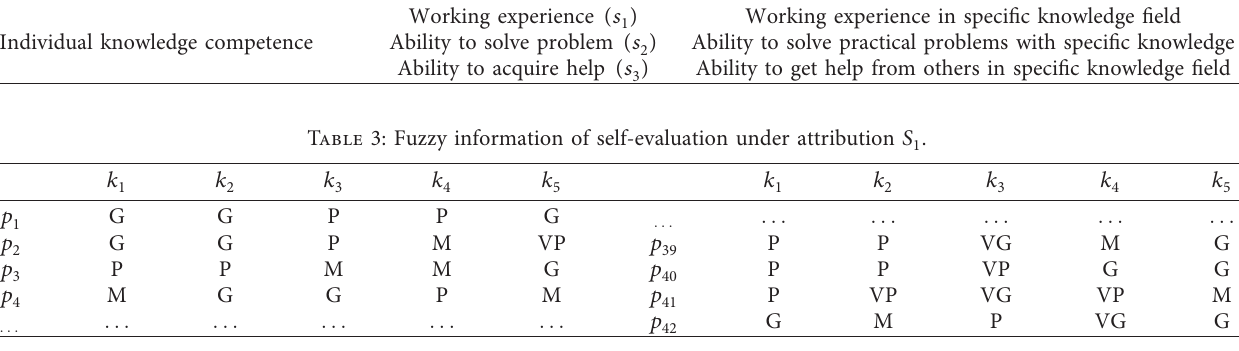
Table 4: Fuzzy information of expert evaluation under attribution S